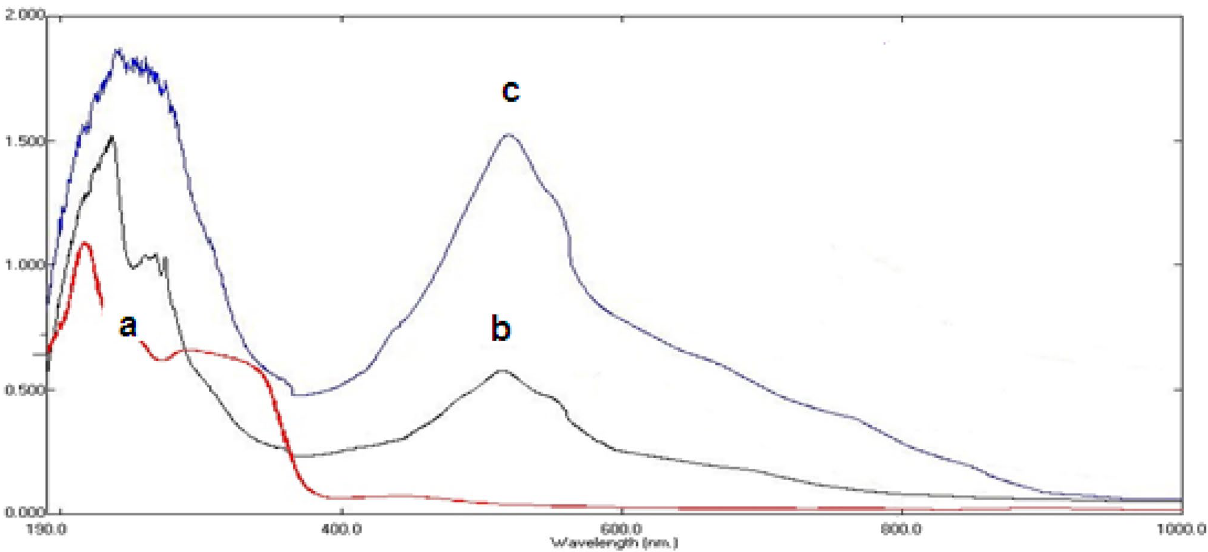
Figure 3. The electronic absorption spectra of (a) Schiff base ligand (A1), (b) Pd complex ( C1) in aqueous solution and (c) TBA.[Pd (A1)] ion associate in organic